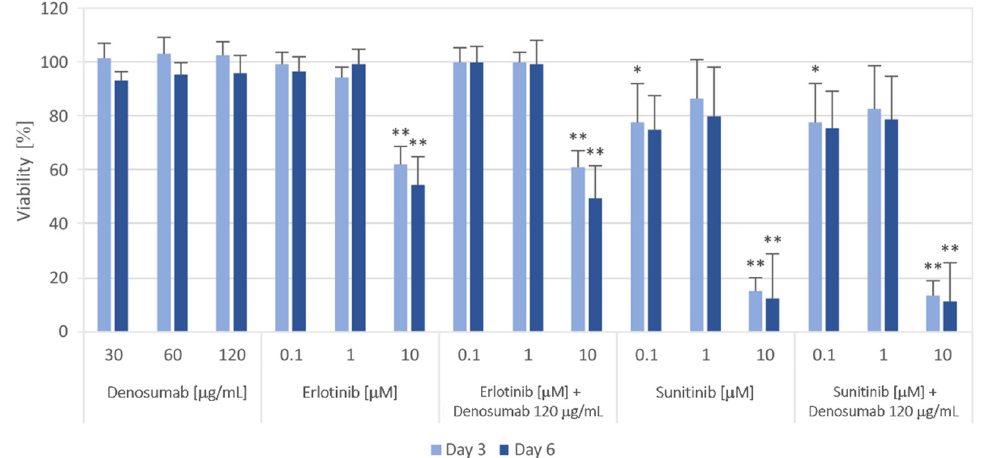
Figure 6. Proliferation of GCTB cell lines after 3 and 6 days of the selected treatment. Cell viability was measured using the MTT assay on Days 3 and 6 of cultivation with different concentrations of the RANKL inhibitor denosumab, EGFR inhibitor erlotinib and PDGFR inhibitor sunitinib or their combinations. The values were compared with those of untreated control cells (untreated controls were set as 100%). The data represent the mean of values of nine analyzed cell lines ± SD. Experiments with each individual cell line were performed in triplicate. * p < 0.05, ** p < 0.01, indicating a significant difference from the control.